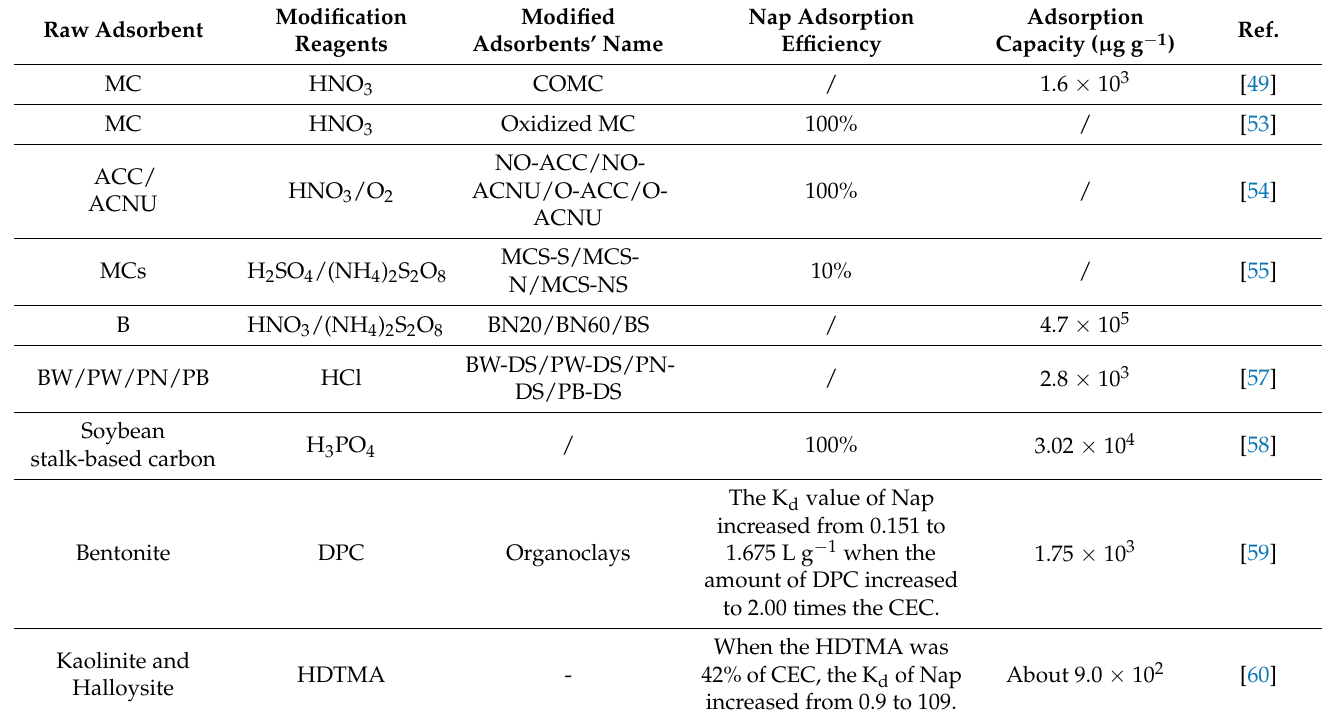
Table 3. Summary of modification reagents, adsorption efficiency, and Nap adsorption capacity of raw and modified